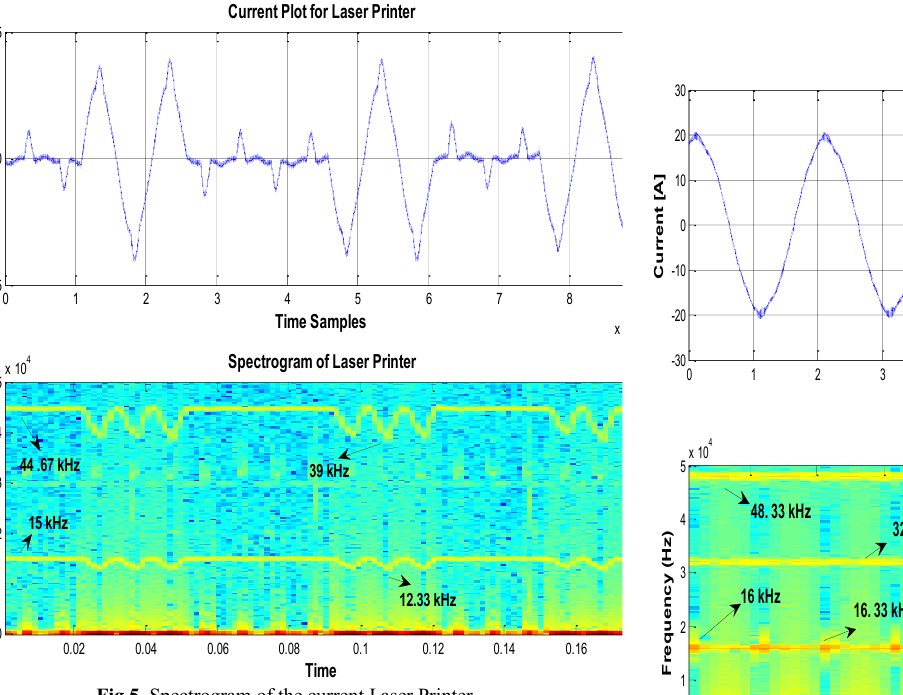
Fig 5. Spectrogram of the current Laser Printer